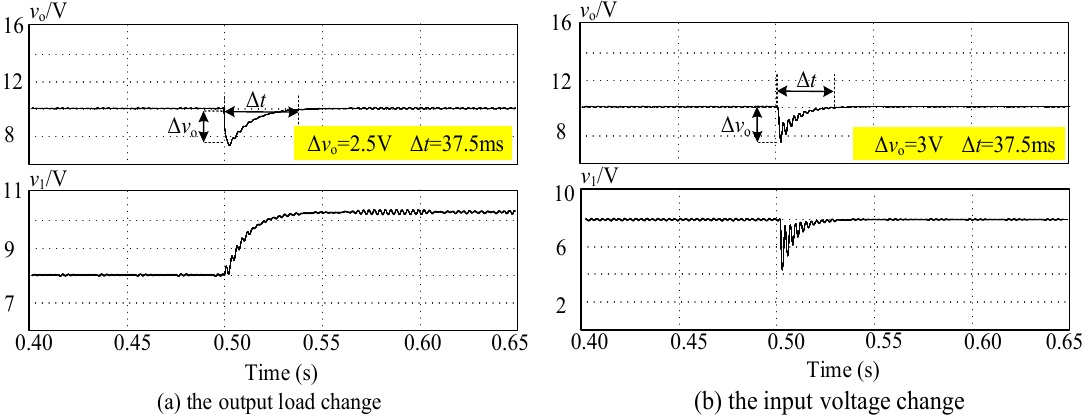
Figure 8. Waveforms of v 1 and v o under PWM control when the output load and input voltage changes.